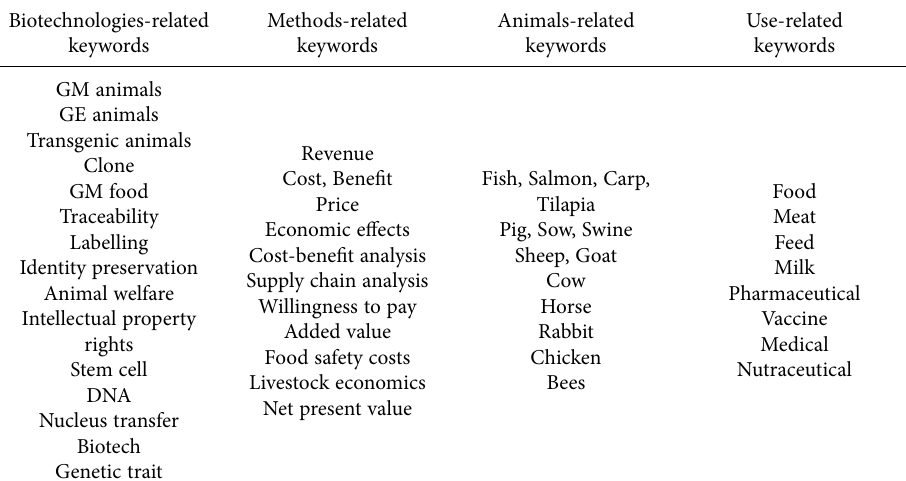
Table 1. Keywords applied in the socio-economic search